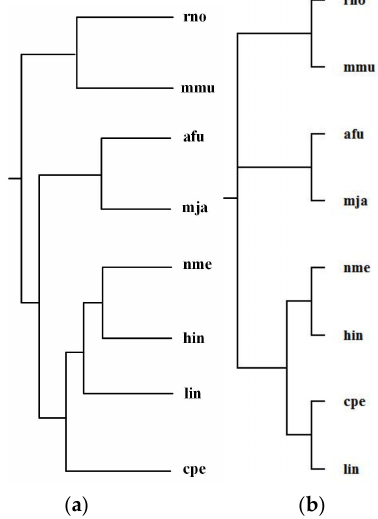
Figure 6. Phylogenetic trees for Archaeoglobus fulgidus (afu), Clostridium perfringens (cpe), Haemophilus influenzae (hin), Listeria innocua (lin), Methanococcus jannaschii (mja), Mus musculus (mmu), Neisseria meningitidis MC58 (nme), and Rattus norvegicus (rno). ( a ) Our tree T 1 and the tree T 2 constructed by MP-Align (T 1 and T 2 are the same). ( b ) The NCBI taxonomy T.